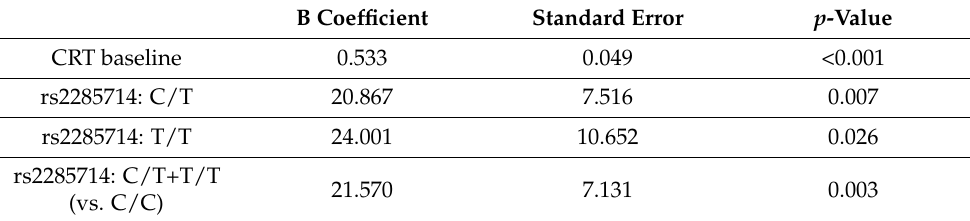
Table 9. Final step of stepwise linear regression showing significant predictors of CRT after 3-IVI.